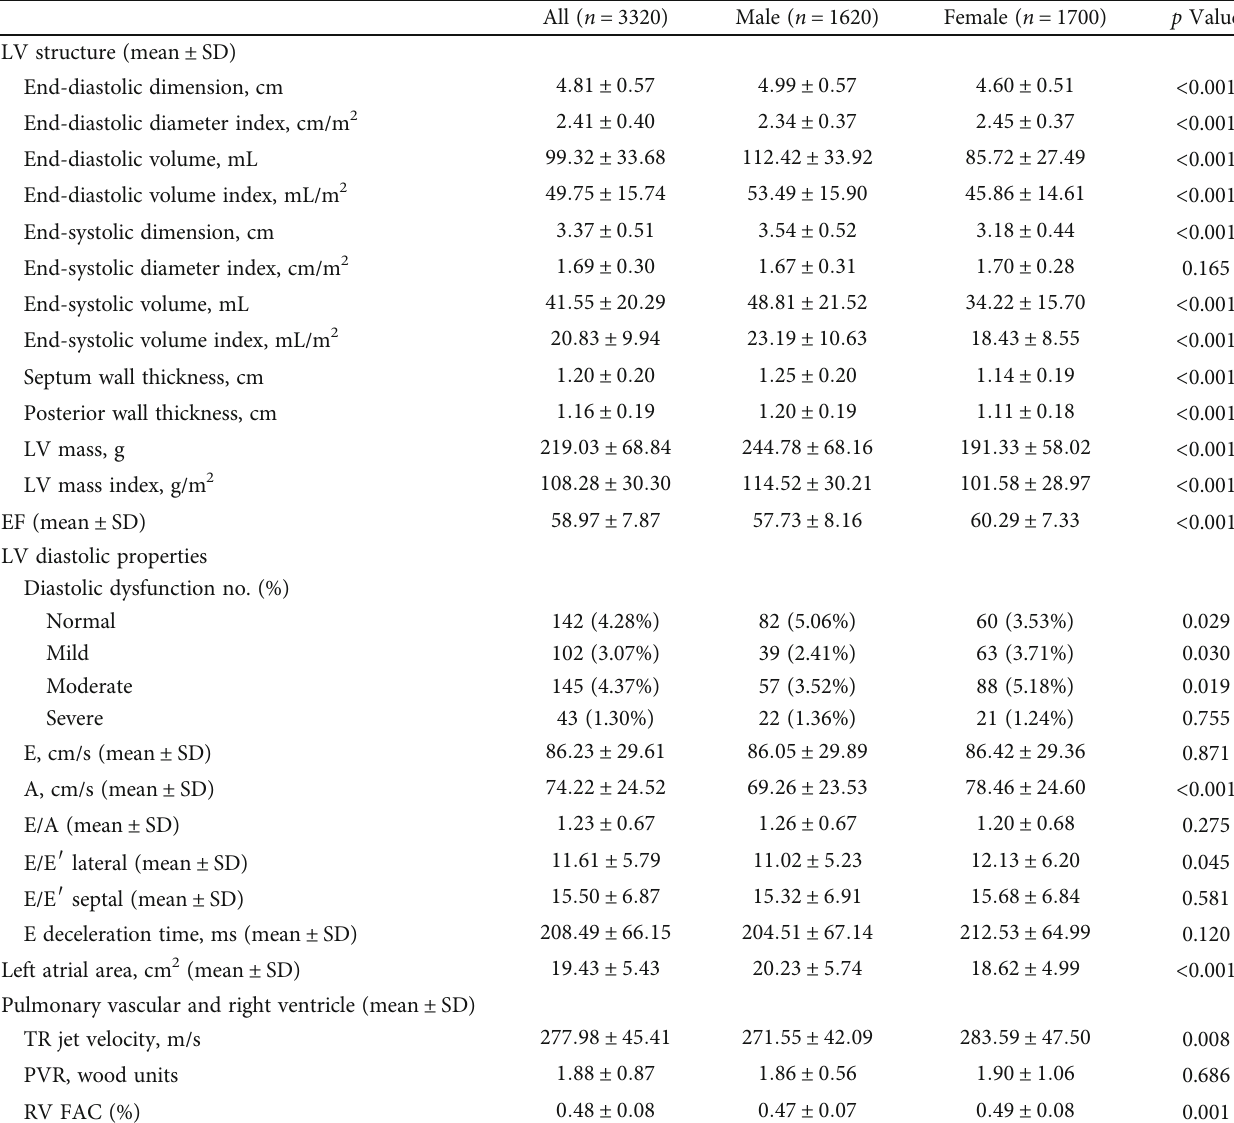
Table 2: Echocardiographic comparisons. All ( n = 3320 ) Male ( n = 1620